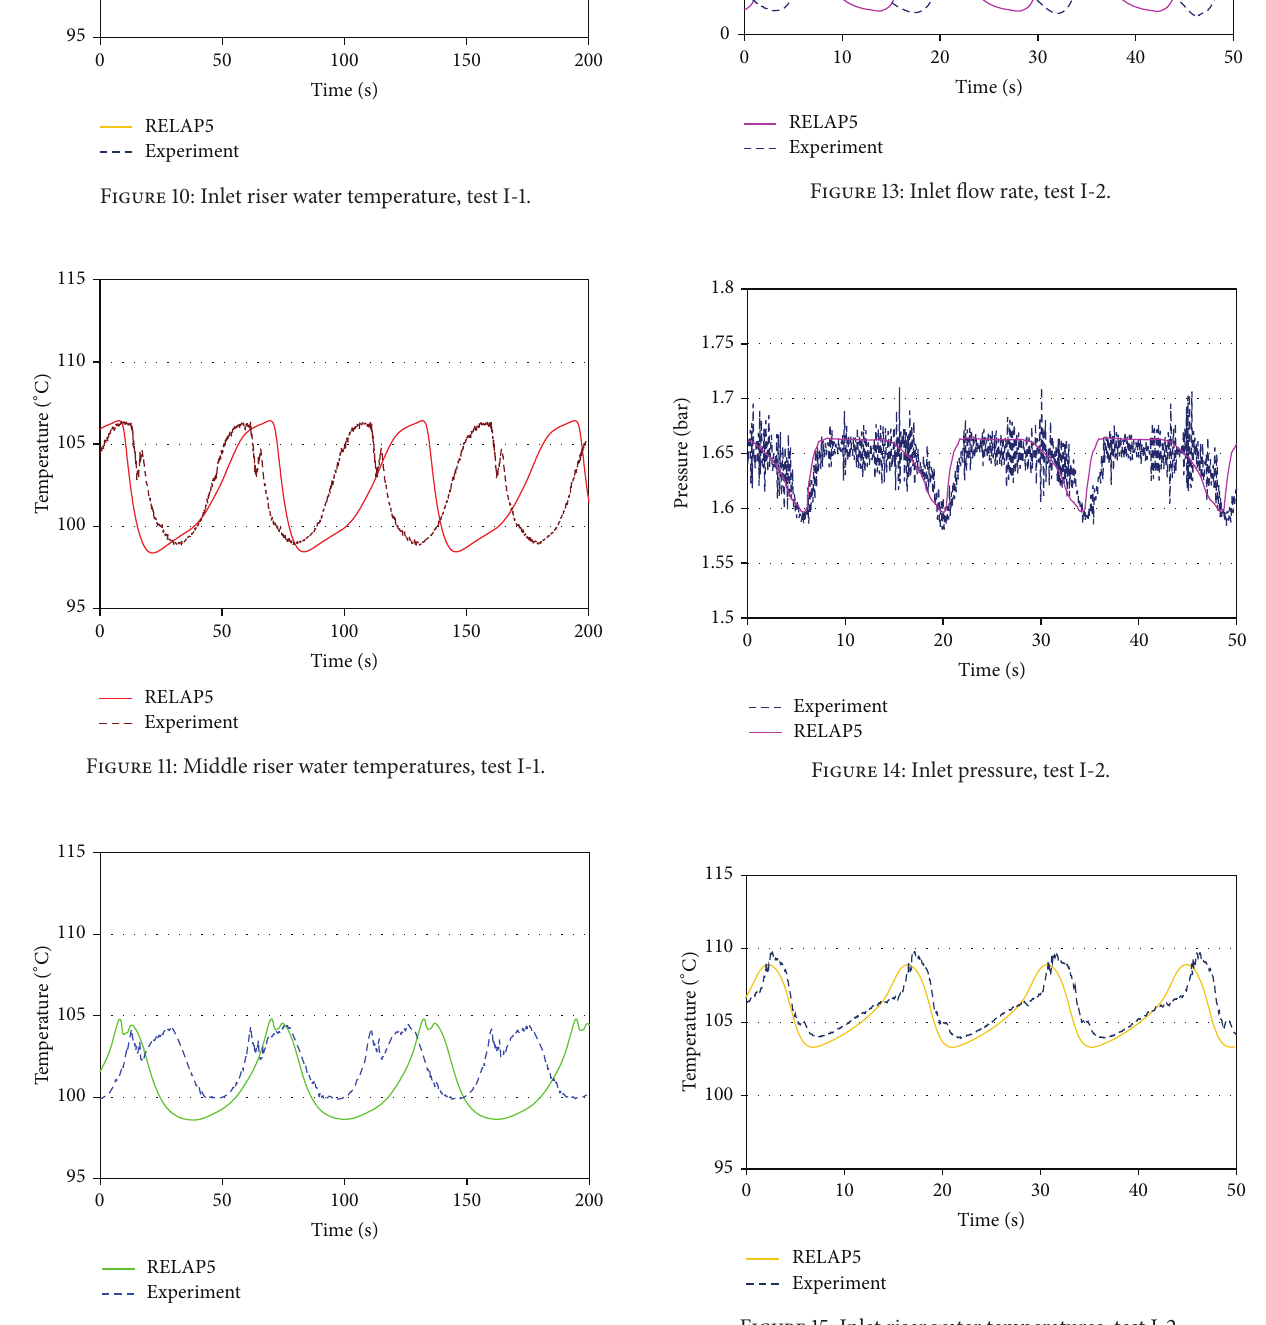
Figure 12: Outlet riser water temperatures, test I-1.